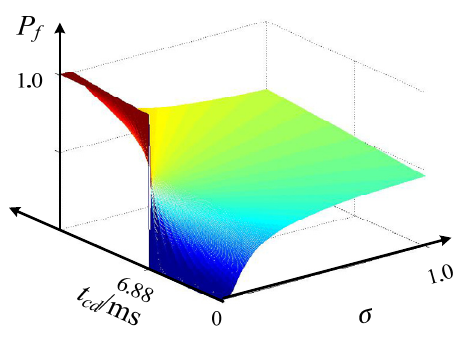
Figure 12. Key factors affecting false trip